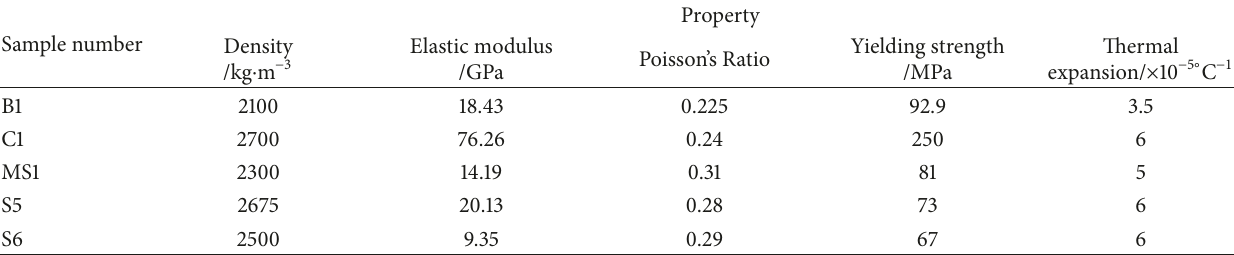
Table 2: Rock properties of different sample.